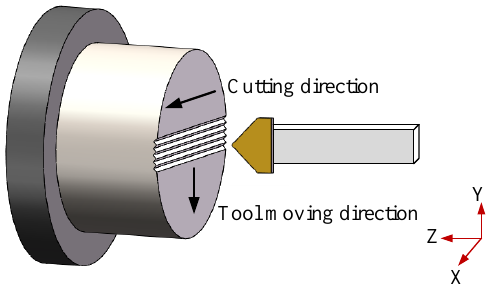
Figure 26. Single point diamond turning process of ChG microstructures.